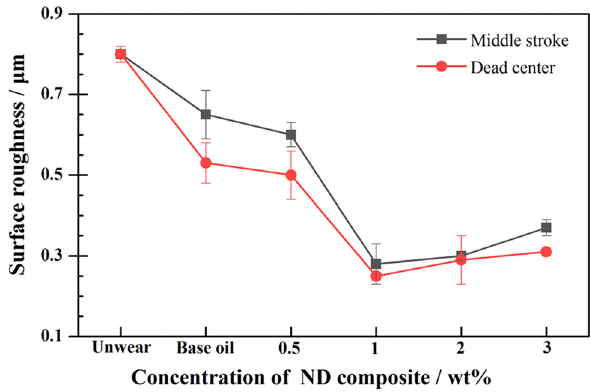
Figure 9: Surface roughness of the Cr liner before and after the